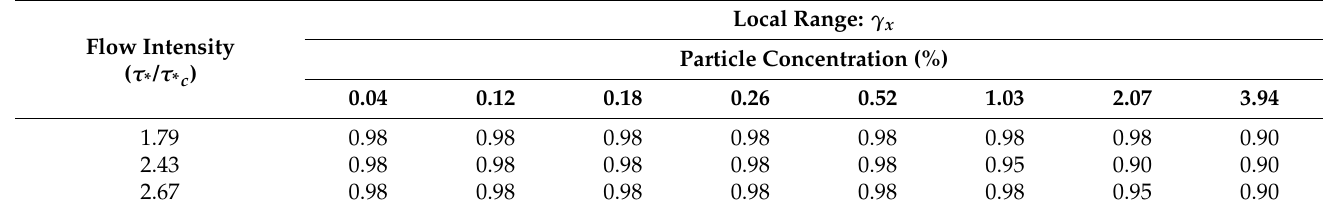
Table 5. Summary of values for 𝛾 𝑥 for particle diffusion in the intermediate range in the X-axis.